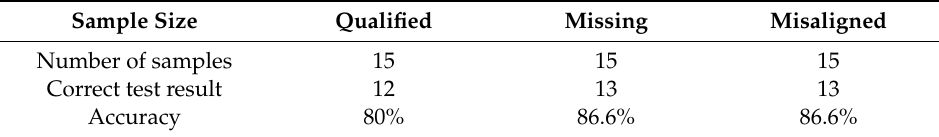
Table 3. Detection results in sample size